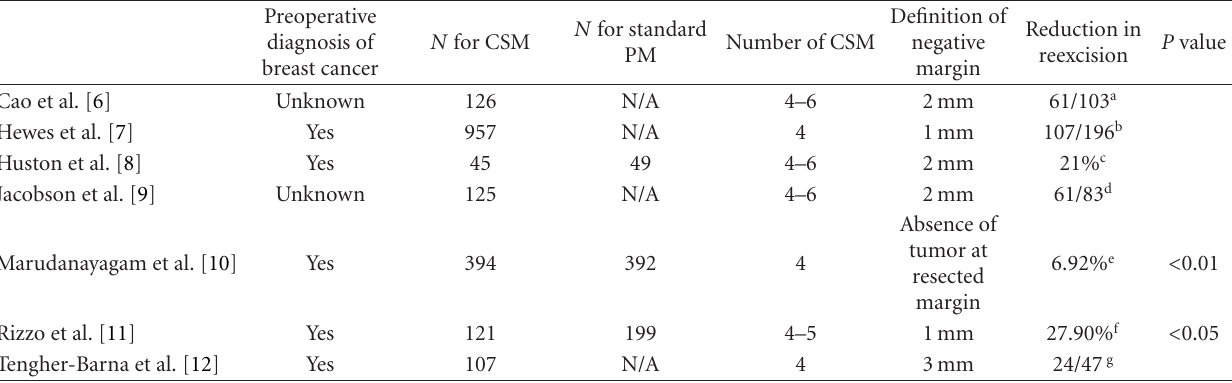
Table 4: Comparison of various